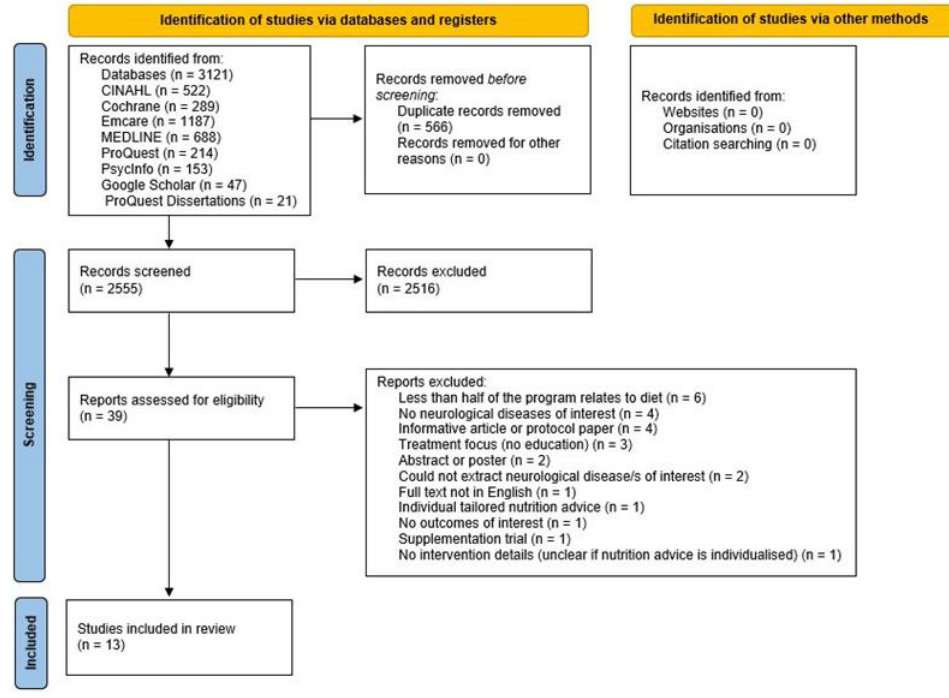
Figure 1. Flowchart showing the scoping review searching and screening processes [30].